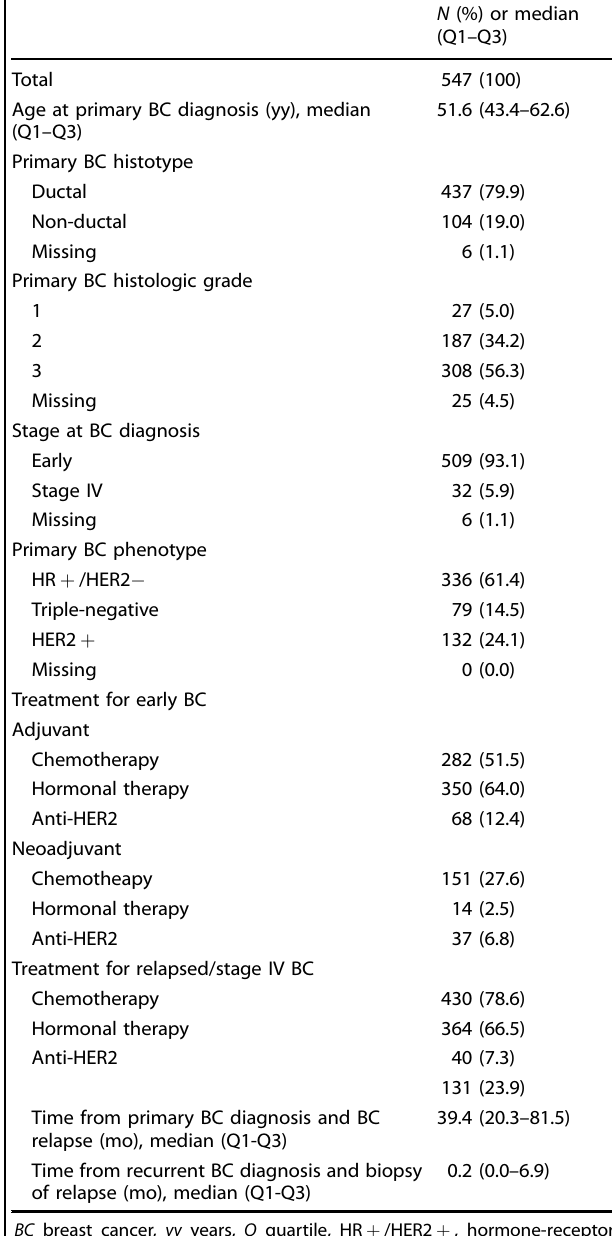
Table 1. Clinicopathological features of the overall population at